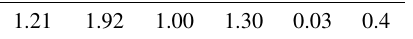
Table 1. Parameters of the k – ε MOST turbulence model; see Sørensen (1995). C ε,